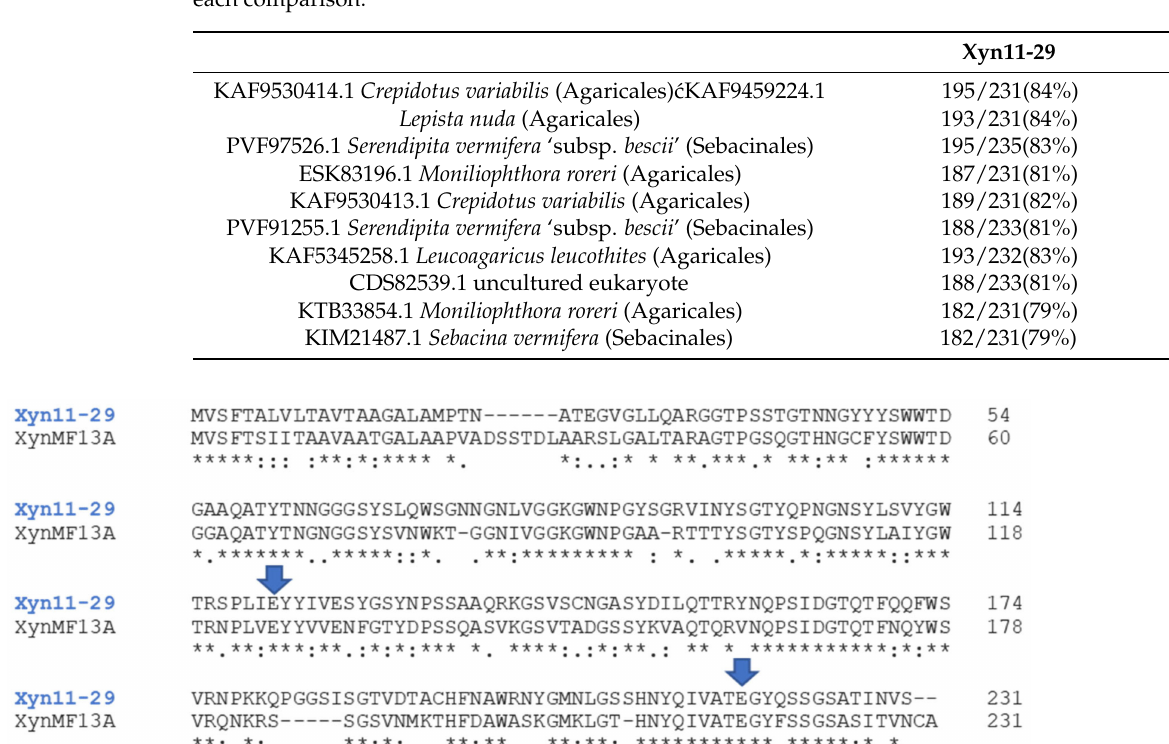
Table 2. Putative xylanases presenting the highest amino acid identities with Xyn11-29. The se- quences (GenBank accession number) and the fungal species are listed with their corresponding order in brackets, together with the percentage of identity and the number of residue pairs considered for each comparison.